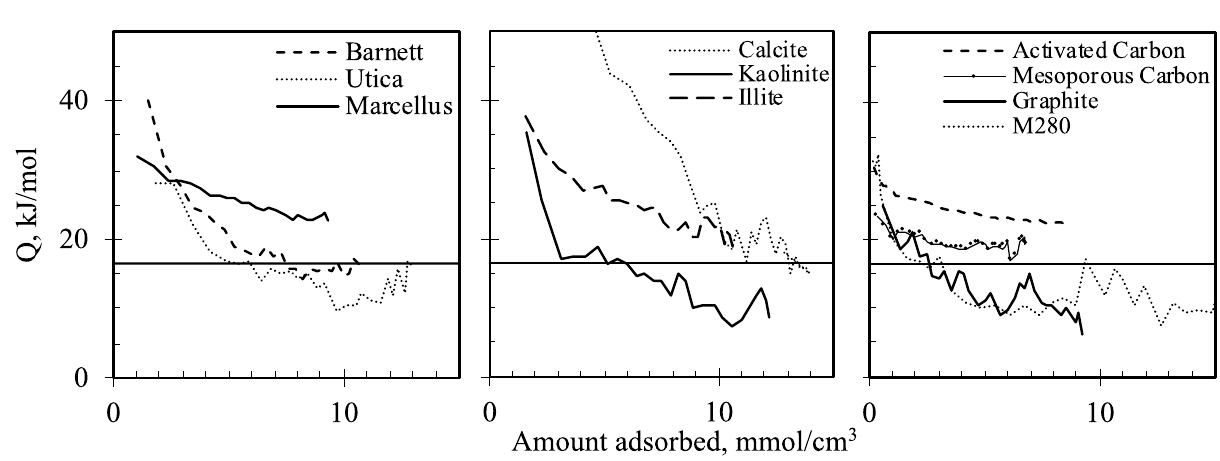
Figure 1. Heat of CO 2 adsorption, horizontal line at 16.4 kJ/mol is heat of CO 2